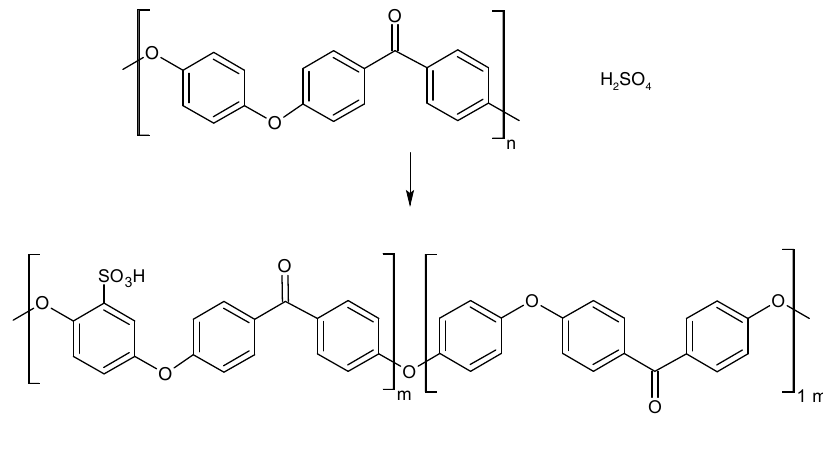
Figure 1. Sulfonation of